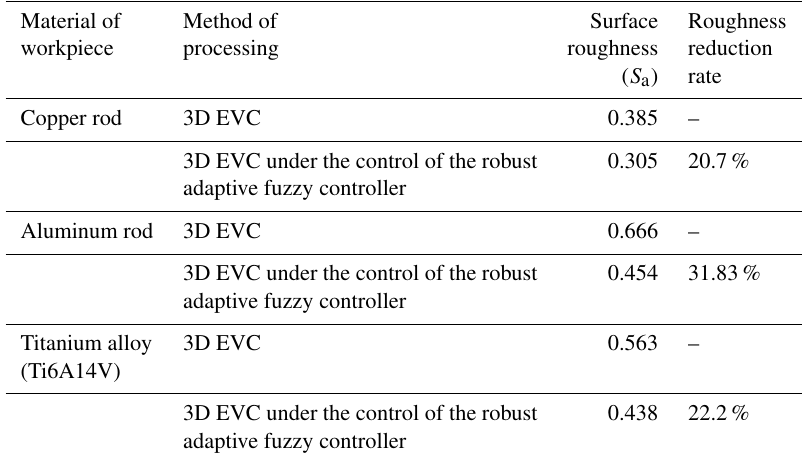
Figure 8. The overall system of cutting experiments. Table 4. Surface roughness values for work parts under both machining